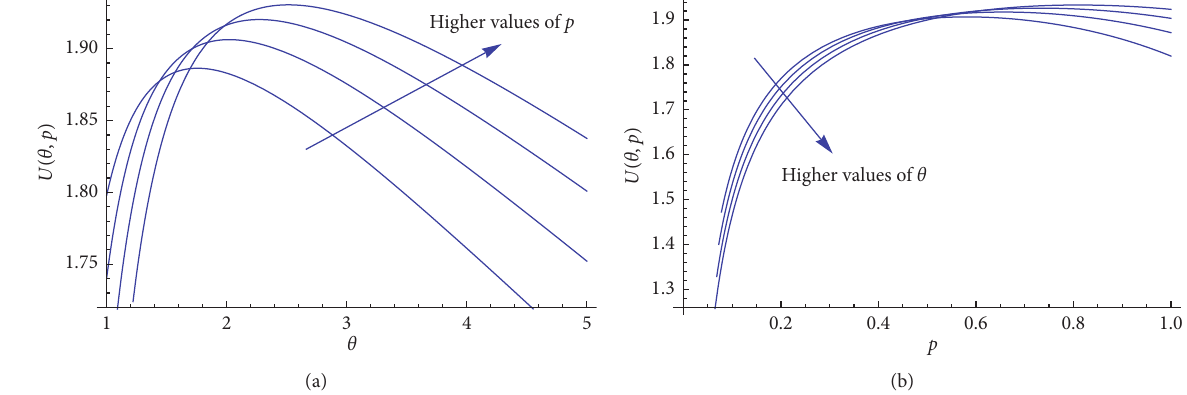
Figure 3: The extended social welfare model: the expected total social welfare U � 0 . 1 ,C � 0 . 2 , C � 0 . 3 , λ � 0 . 5 , λ � 0 . 6 , β � 0 . 8 , β � 0 . 4 , c � 0 . 5 , and δ � 0 . 8. 0 . 1 ,C 3 4 5 0 1 1 2